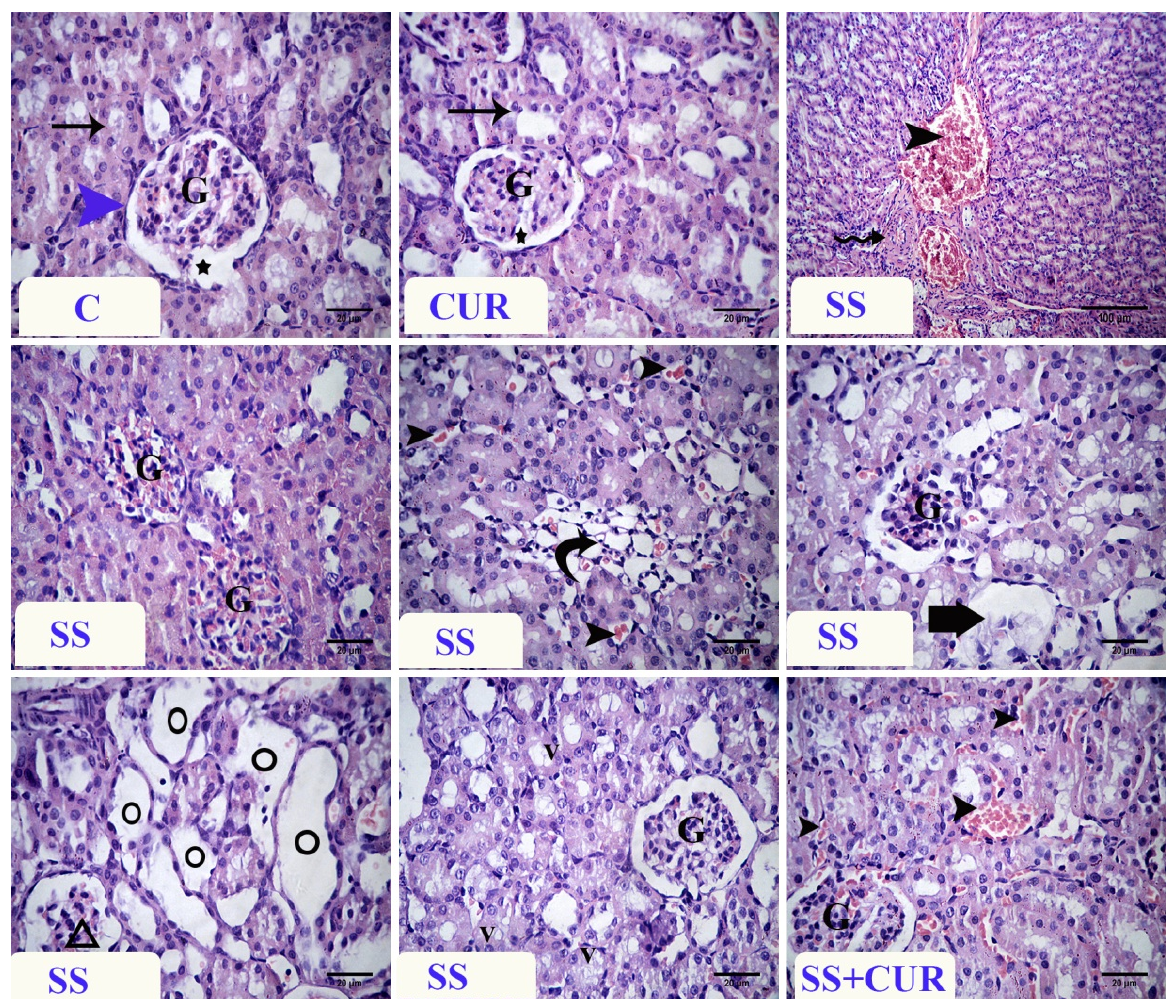
Figure 3. Photomicrograph of H&E-stained renal tissue sections. Control ( C ) and curcumin (CUR) group showing the normal glomeruli (G), renal tubules (arrows), outer layer of Bowman’s capsule (blue arrowhead), and capsular space (star). Sodium salicylate (SS)-treated group showing vascular congestion (arrowhead) and hyalinization of the blood vessel (zigzag arrow), absence of capsular space and glomerular congestion (G), coagulative necrosis (curved arrow), congestion of peritubular capillaries (arrowheads), absence of glomerular tuft (thick arrow), tubular dilation (circles) shrinkage of the glomerulus (triangle), and vacuolation of the lining epithelium of tubules (v). SS + CUR-treated group showing vascular congestion (arrowheads) and normal glomeruli (G). The magnification was ×400 in all photos, except the first one of SS was ×100.